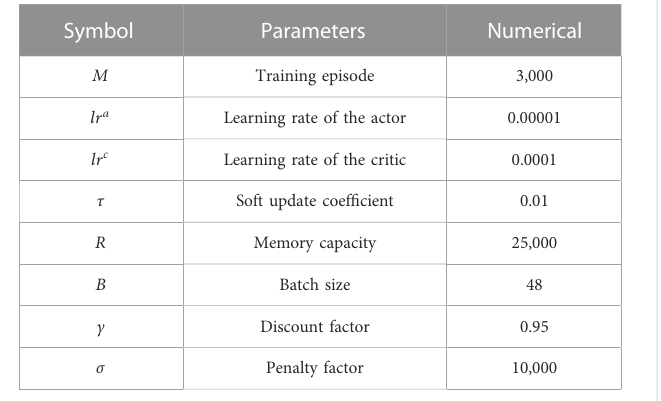
TABLE 3 Parameters of the proposed DDPG algorithm.